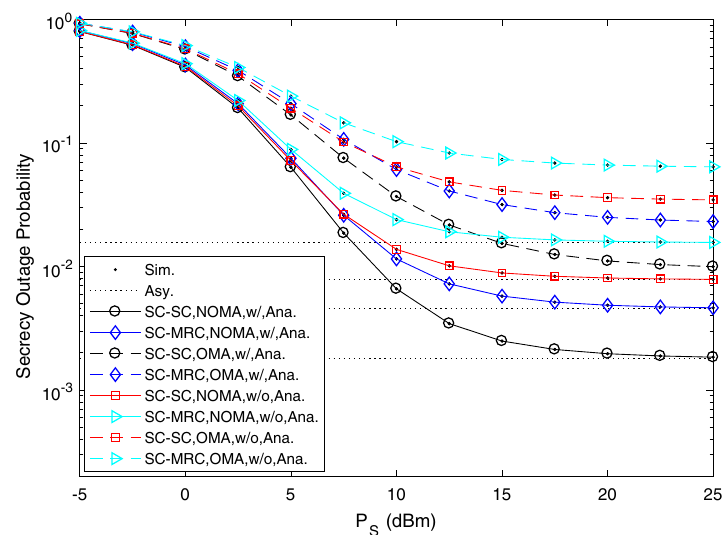
Fig. 2 The theoretical results and simulation results of SOP versus transmit power. The SOP of the four cases for NOMA VS